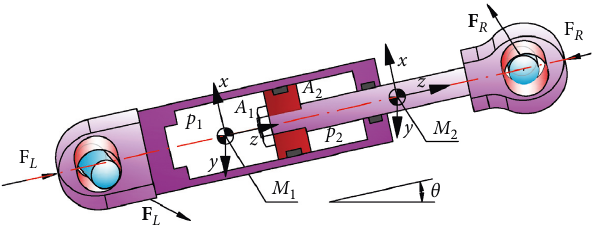
Figure 10: Hydraulic cylinder and forces